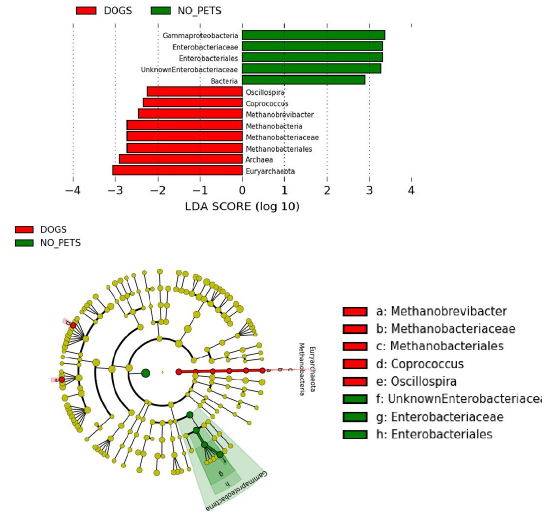
Figure 3. Cladogram representing the taxonomic hierarchical structure of the identified differences between dog owners and non-pet owners using Linear discriminant analysis effect size. Each filled circle represents one phylotype. Red, bacterial taxa statistically overrepresented in dog owners; green, bacterial taxa overrepresented in non-pet owners. Phylum and class are indicated in their names on the cladogram and the order, family, or genus are given in the key.